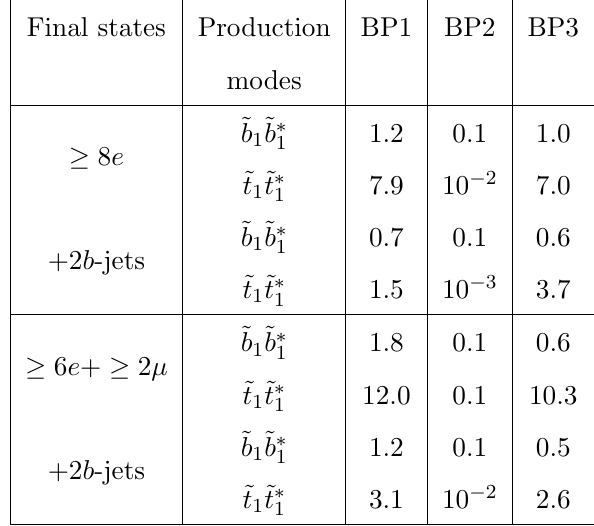
Table 7. Final state numbers for the benchmark points at 100 fb (cid:0) 1 at the LHC with 14 TeV, where the contributions are from ~ b 1 ~ b (cid:3) and ~ t 1 ~ t (cid:3) 1 1